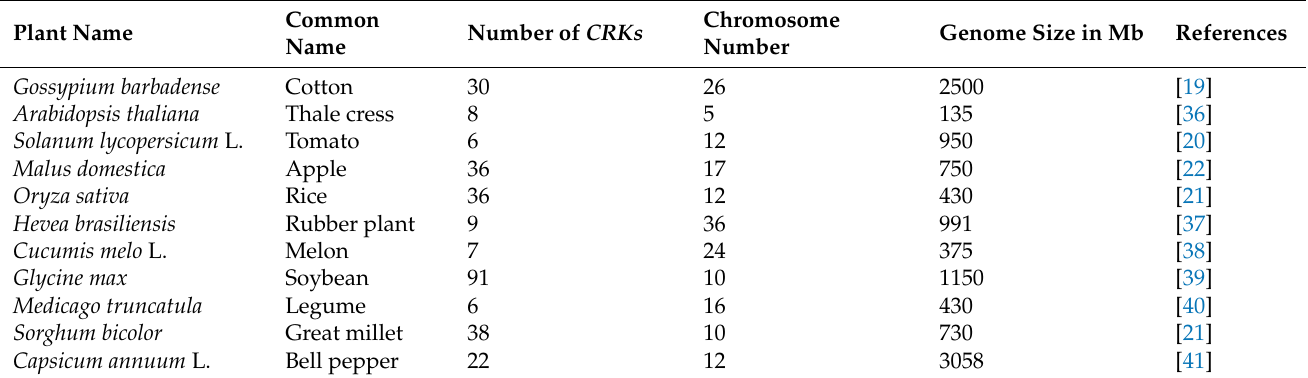
Table 1. Identification of the CRK gene family in other plant